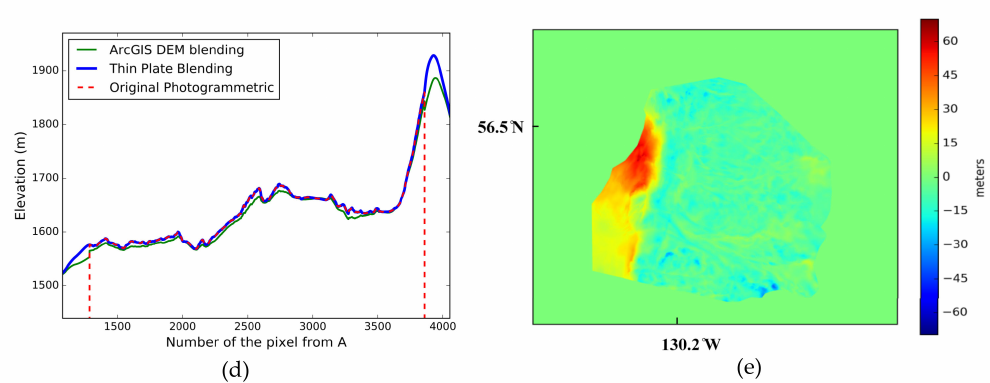
Figure 12. DSM blending, Boundary Range Slide. ( a ) Thin-plate blended DSM; ( b , c ) zoom of the red box in ( a ) for thin-plate blended and ArcGIS blended DSMs, respectively; ( d ) height profile along the A–B transect shown in ( a ); ( e ) difference between photogrammetric and ArcGIS blended DSM over the red box in ( a